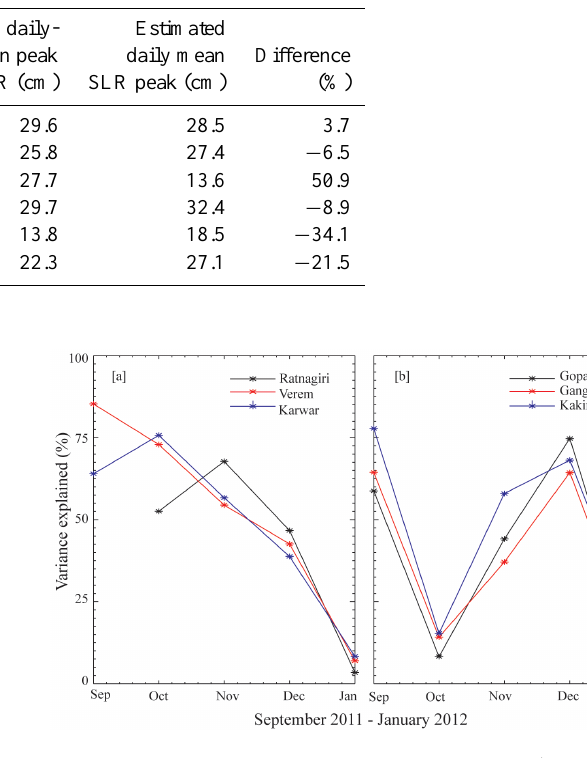
Figure 8. Daily mean sea-level variability explained (Var e %) by the multi-linear regression during different months from Septem- ber 2011 to January 2012. (a) Var e (%) at Ratnagiri (black), Verem (red) and Karwar (blue). (b) Var e (%) at Gopalpur (black), Gan- gavaram (red) and Kakinada